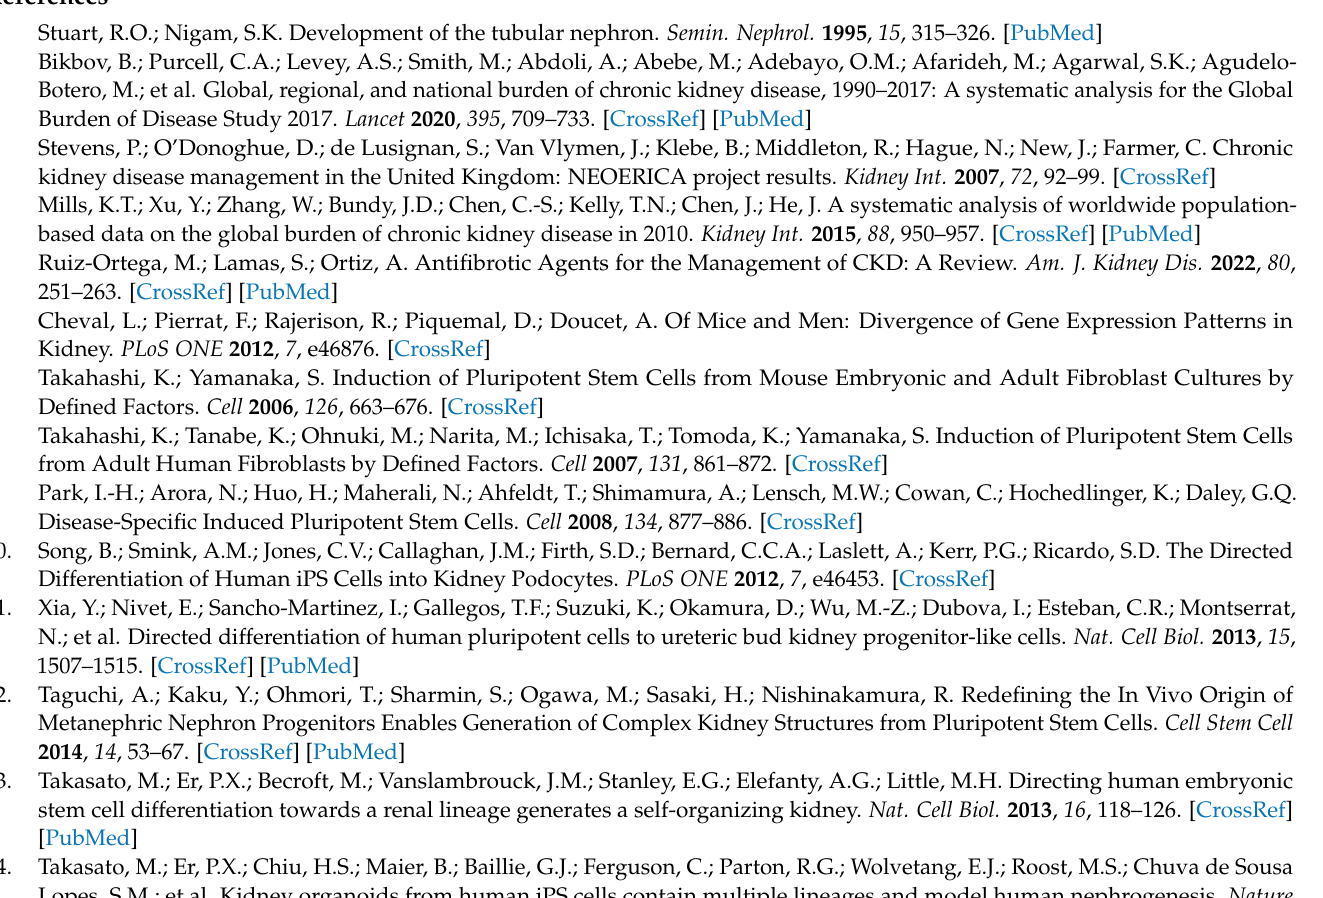
mentary Table S1: Primer information; Supplementary Figure S1: Expression of renal genes measured by reverse transcriptase polymerase chain reaction